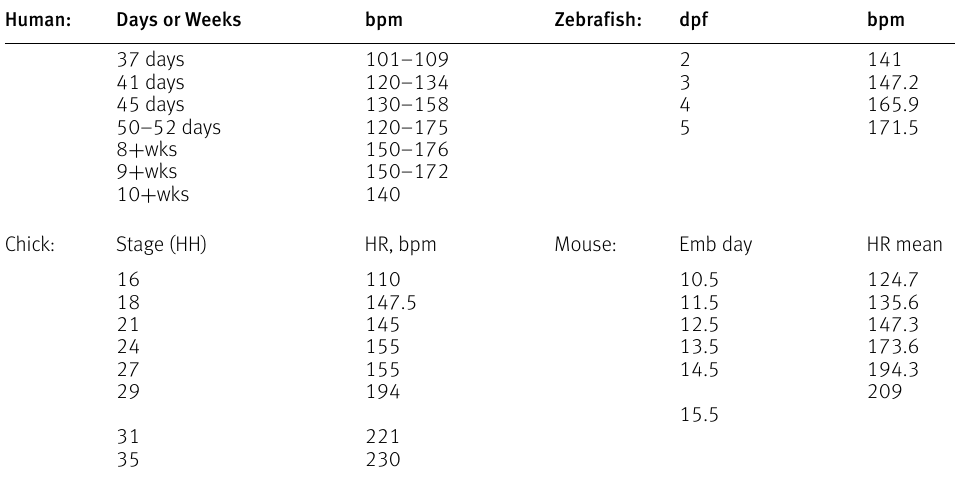
Table 2. Heart rate across developmental animal models. Adapted from